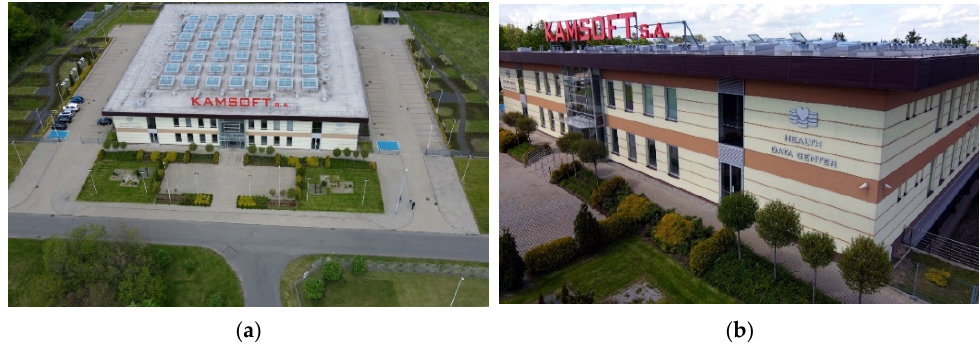
Figure 1. Case study building for this research. ( a ) top view of the building, ( b )front of the building.